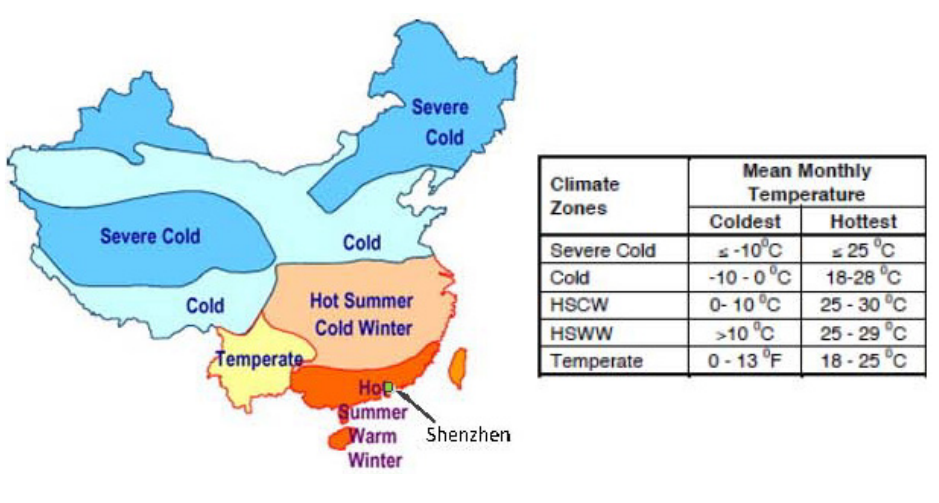
Figure 3. Climate zones in China. Shenzhen is located in the Hot Summer Warm Winter Zone. Source: Huang and Deringer (2007) and MOHURD (1993)